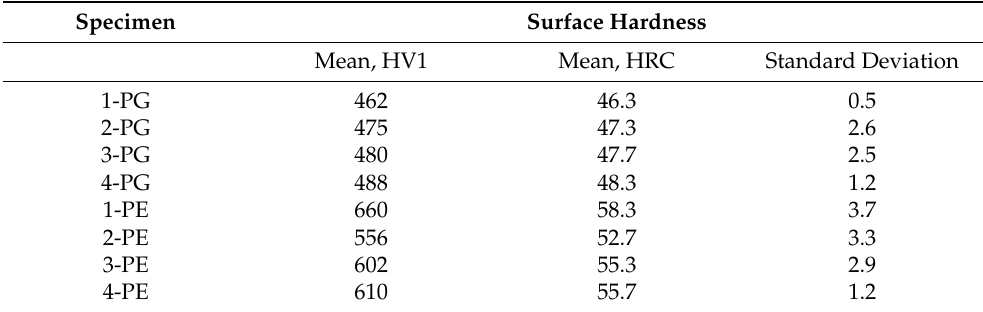
Table 8. Measured Rockwell hardness on the surface of the surface layers for samples prepared by each MMC